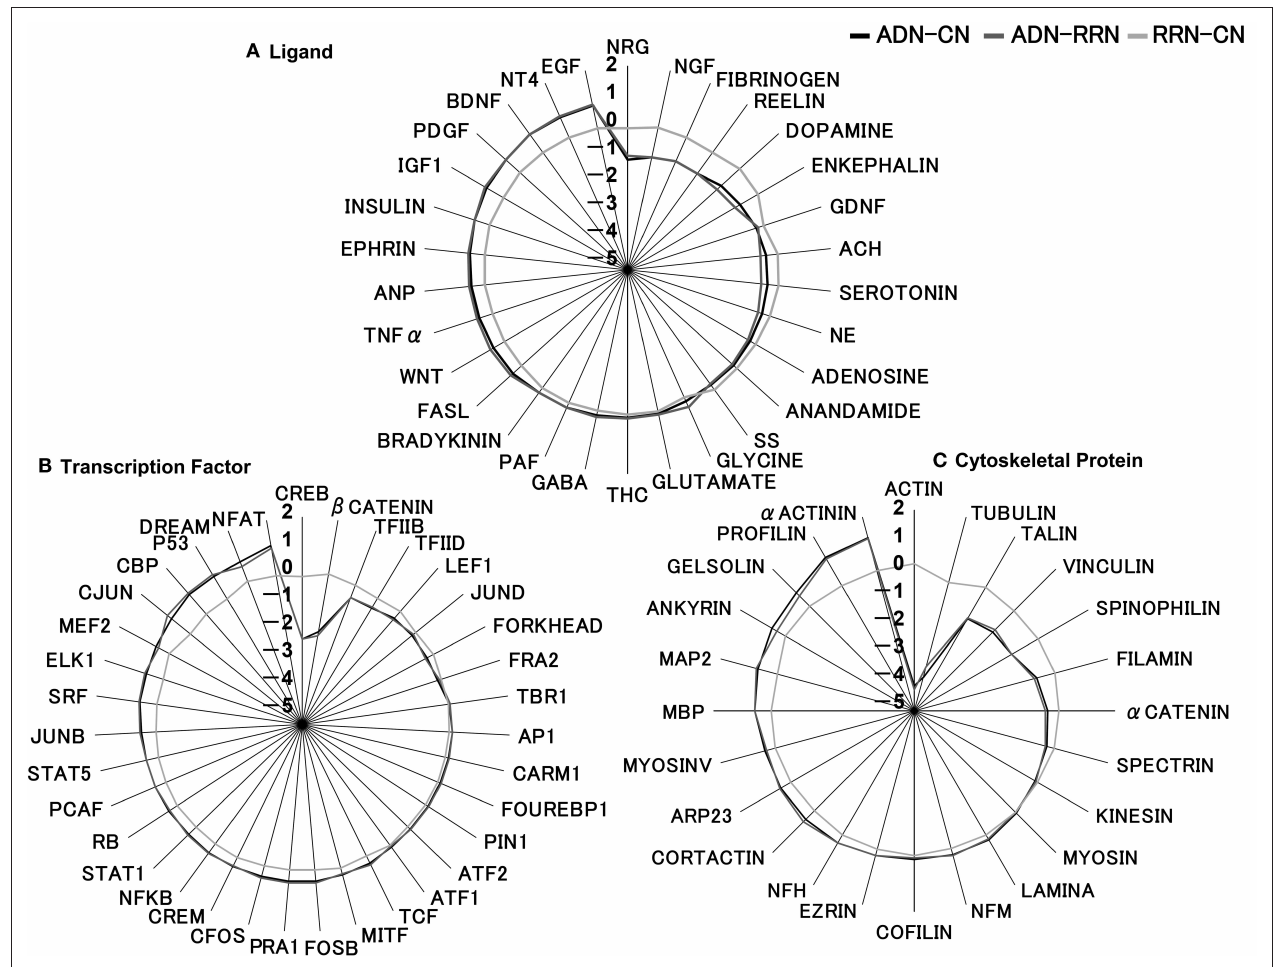
FIGURE 4 | Robustness of inputs and outputs in ADN subtracted by CN, ADN subtracted by RRN, and RRN subtracted by CN ( k = 9). (A) Robustness analysis of the pathway from certain ligands to all outputs (transcription factors and cytoskeletal proteins). The R -value range of inputs was between 0.8 and − 1.2. Robustness analysis showed a large decrease in signal molecules associated with NRG, which a substrate of BASE1. EGF and the neurotrophin family, which includes BDNF and NT4, showed an increase in associated signal molecules. (B) Robustness analysis of the pathway from all ligands to certain transcription factors ( R -value range, − 2.1 to 1.1). (C) Robustness